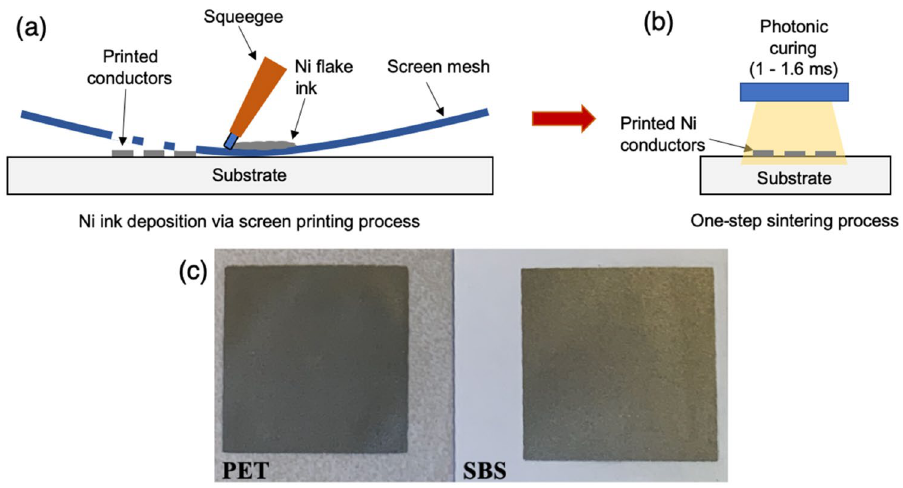
Figure 1. Schematics of electrode preparation: ( a ) screen printing, ( b ) photonic curing process and ( c ) sintered Ni on PET and